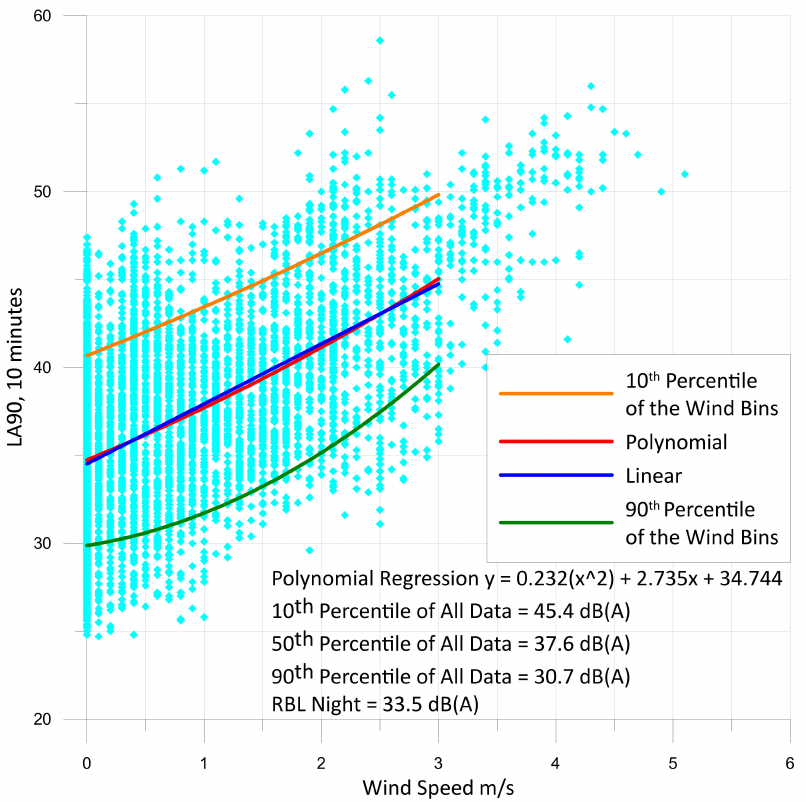
Figure 12. Waubra Wind Farm Nighttime Regression Curve-Post Construction, wind and noise at 1.5 m AGL, 12 June–11 September